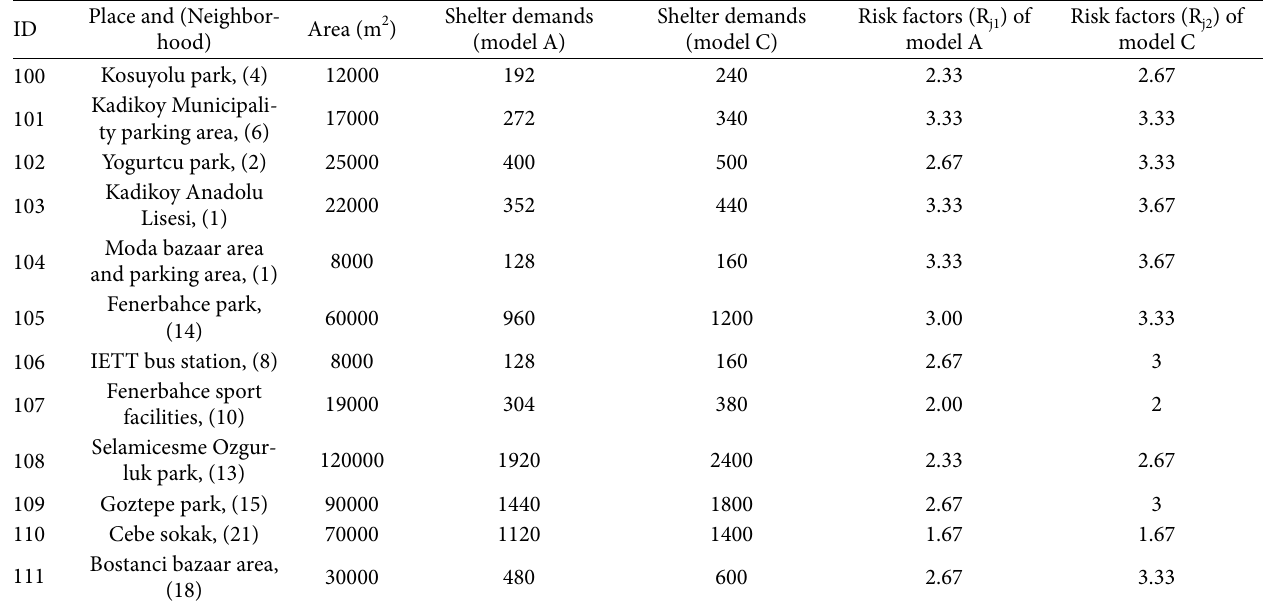
Table 3: Data of temporary shelter areas